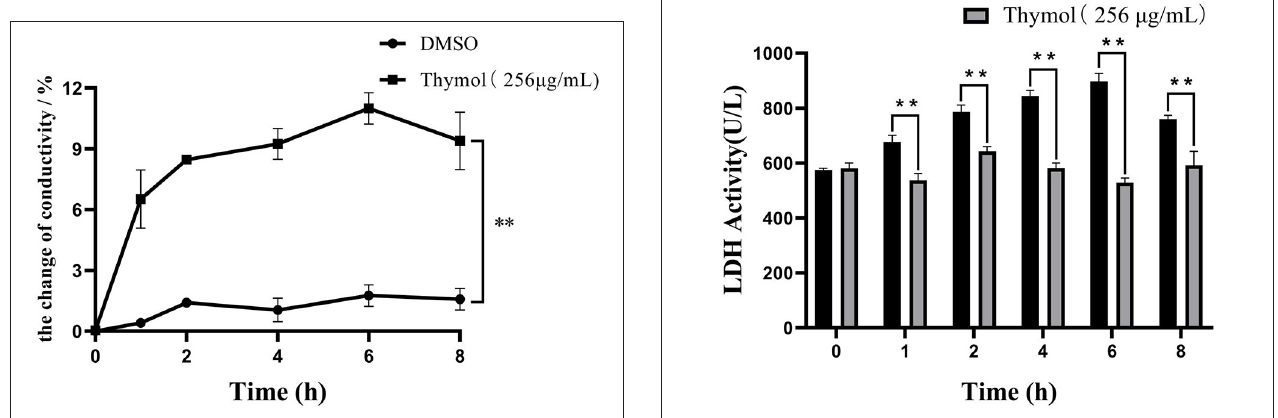
FIGURE 5 | Thymol inhibited the LDH activities of strain HT with a time-dependent manner. ** p < 0.01 when compared with control group at the same time point.